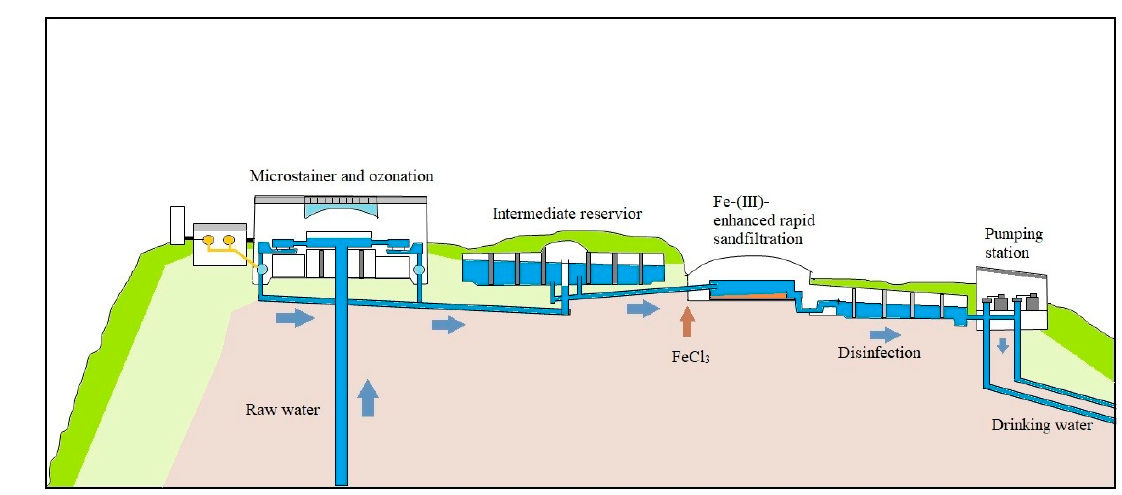
Figure 1. Schematic diagram of processes at the Lake Constance Water Supply Treatment Plant.